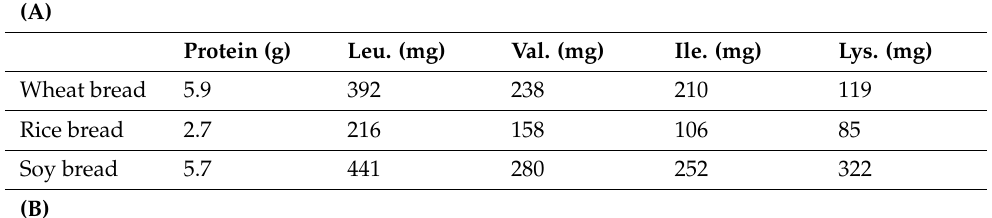
Figure 5. ( A ) Essential amino acid contents of different bread types; ( B ) Non-essential amino contents of different bread types. Table 1. ( A ) Protein, amino acid contents in terms of BCAAs and lysine in 70 g of bread, and ( B ) recipes used in bread